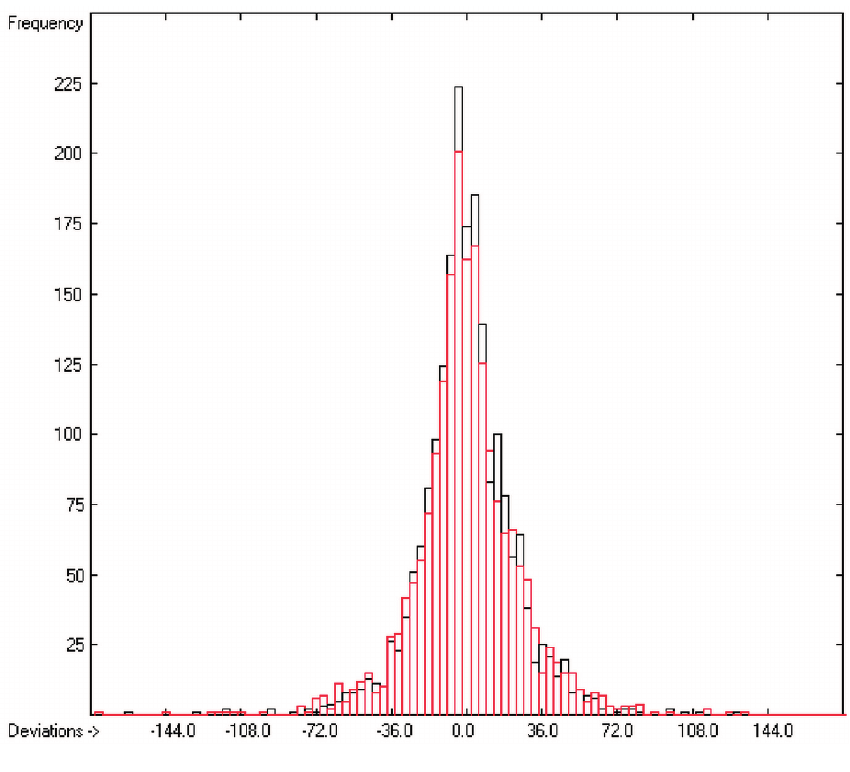
Figure 2. Histogram of heat-of-combustion data (S = 25.2).